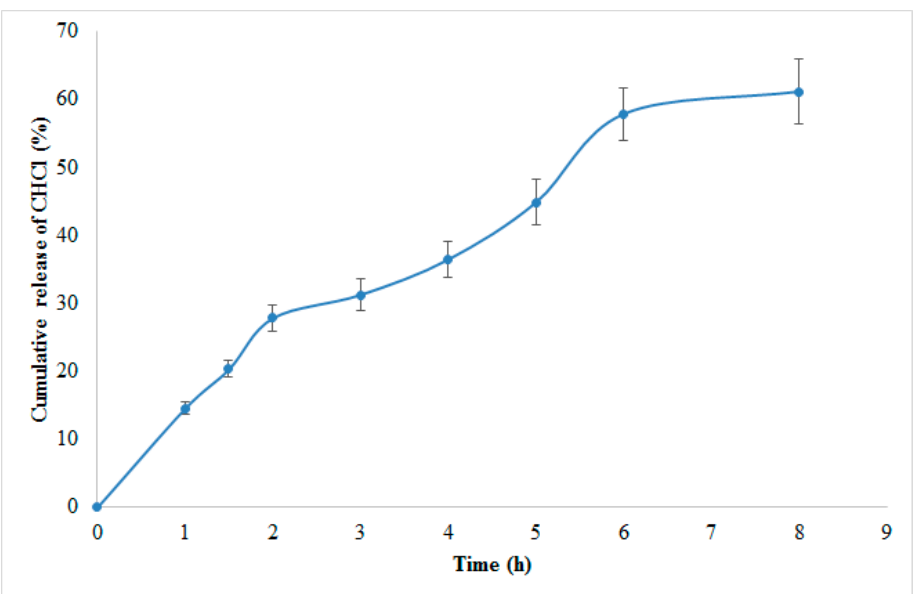
Molecules 2022 , 27 , x FOR PEER REVIEW Figure 7. CHCl percent amount released from the optimized NPs in phosphate buffer (pH 7.4, 37 °C).